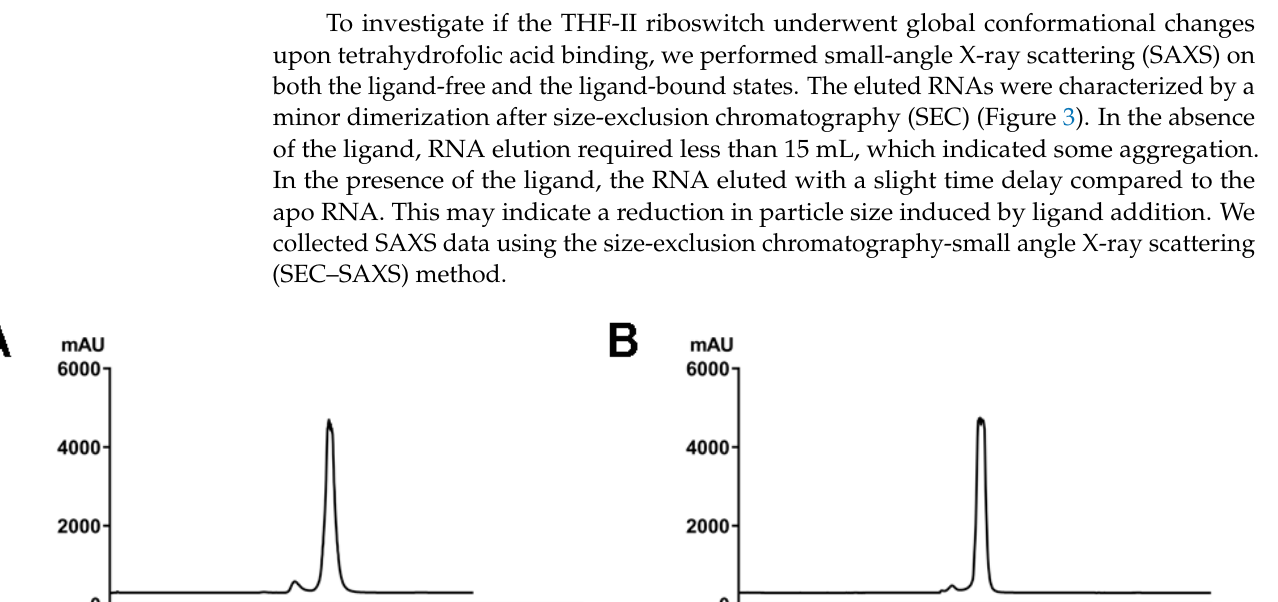
Figure 2. Tetrahydrofolic acid recognizes the THF − II riboswitch. SHAPE analysis showed that tet- rahydrofolic acid specifically recognizes the THF − II riboswitch Loop regions. The colored bars rep- resent reduced SHAPE reactivity upon ligand binding. Residues are indicated on the X − axis. The coloring of the THF − II riboswitch with SHAPE signal is consistent with the secondary structure in Figure 1. The P1, P2 and P3 stems of the RNA are labeled in dark khaki, orange and blue, respec- tively. The GGAG − connected P1 and P2 are shown in purple. The Loop1 and Loop2 residues are shown in pink and green.